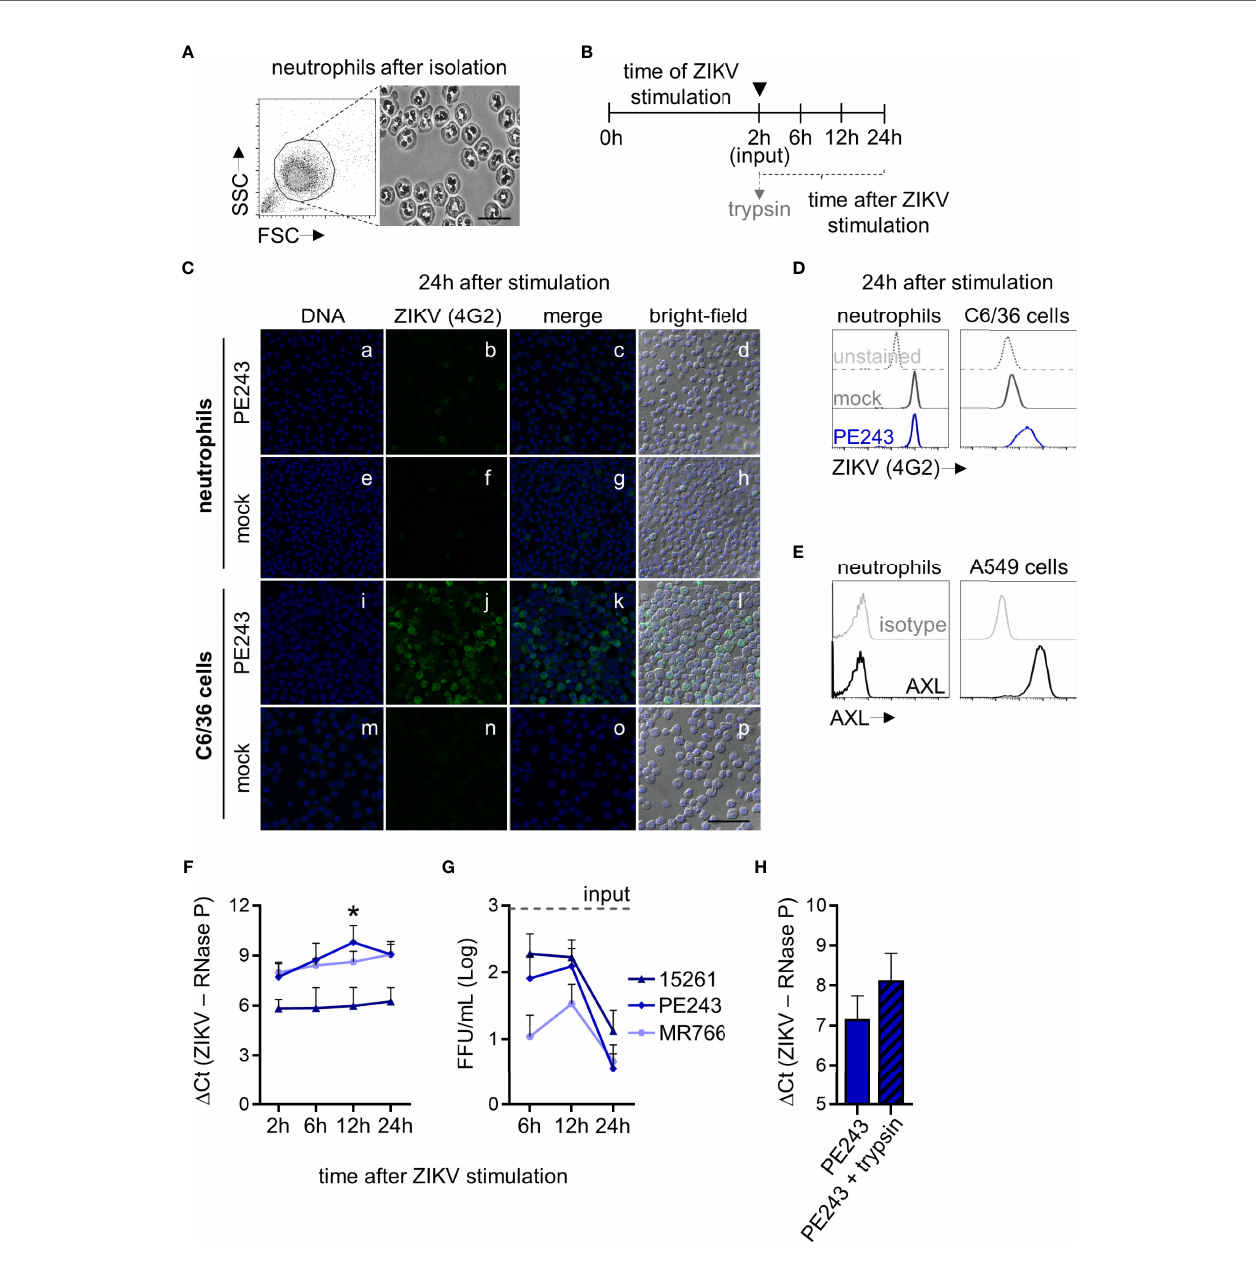
FIGURE 1 | ZIKV does not replicate in human neutrophils. (A) Neutrophils morphological features after isolation shown by fl ow cytometry and microscopy (bright- fi eld, bar = 25 µm, magni fi cation = 100x.). (B) The cells were stimulated in vitro for 2 hours with ZIKV BR 2015/15261, ZIKV PE243, ZIKV MR766 (1 MOI), or mock (C6/36 cells-conditioned media in an equivalent volume of ZIKV strains). Then, neutrophils were washed to remove the stimuli (indicated by ▼ ) and evaluated directly after (2 hours) and at 6, 12, and 24 hours after stimulation. When indicated, neutrophils were treated with trypsin after the wash step at 2 hours of stimulation with ZIKV strains. (C) Immunostaining of neutrophils with 4G2 (E protein; green) at 24 hours after ZIKV PE243 (a-d) or mock (e-h) stimulation. Nuclei (blue) were stained with Vybrant DyeCycle Violet. Merge of these stains and the bright- fi eld colocalization are also shown. C6/36 cells (l-p) were used as a positive infection control (bar = 50 µm, magni fi cation = 40x.) (D) Histograms showing 4G2 intensity of fl uorescence in neutrophils and C6/36 cells at 24 hours after mock and ZIKV PE243 stimulation, as measured through fl ow cytometry. Infected-unstained cells were used as a negative fl uorescence control. (E) Histograms showing AXL receptor intensity of fl uorescence in neutrophils and A549 cells. An isotype control antibody was used as a negative fl uorescence control. One result that is representative of three independent experiments is shown. (F) RNA levels of ZIKV strains in neutrophils at 2, 6, 12, and 24 hours after stimulation. (G) ZIKV loads on neutrophil culture supernatant at the same time after stimulation with ZIKV strains. The dashed line named input represents the mean of the titers of the three ZIKV strains that were still detected on the supernatant after stimuli removal after 2 hours of stimulation. (H) RNA levels of ZIKV PE243 detected in neutrophils treated or not with trypsin after 2 hours of stimulation. Bars indicate the standard error of the mean (SEM). Three-four independent experiments are shown (n = 9-15). The asterisk (*) denotes the statistical difference between 6 and 12 hours of the ZIKV PE243